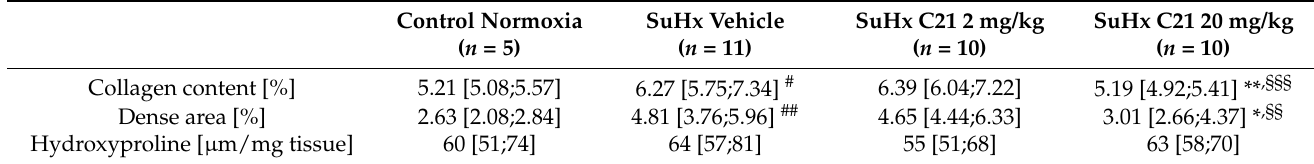
Table 1. Collagen, dense area, and hydroxyproline in the lungs of rats exposed to Sugen-hypoxia.